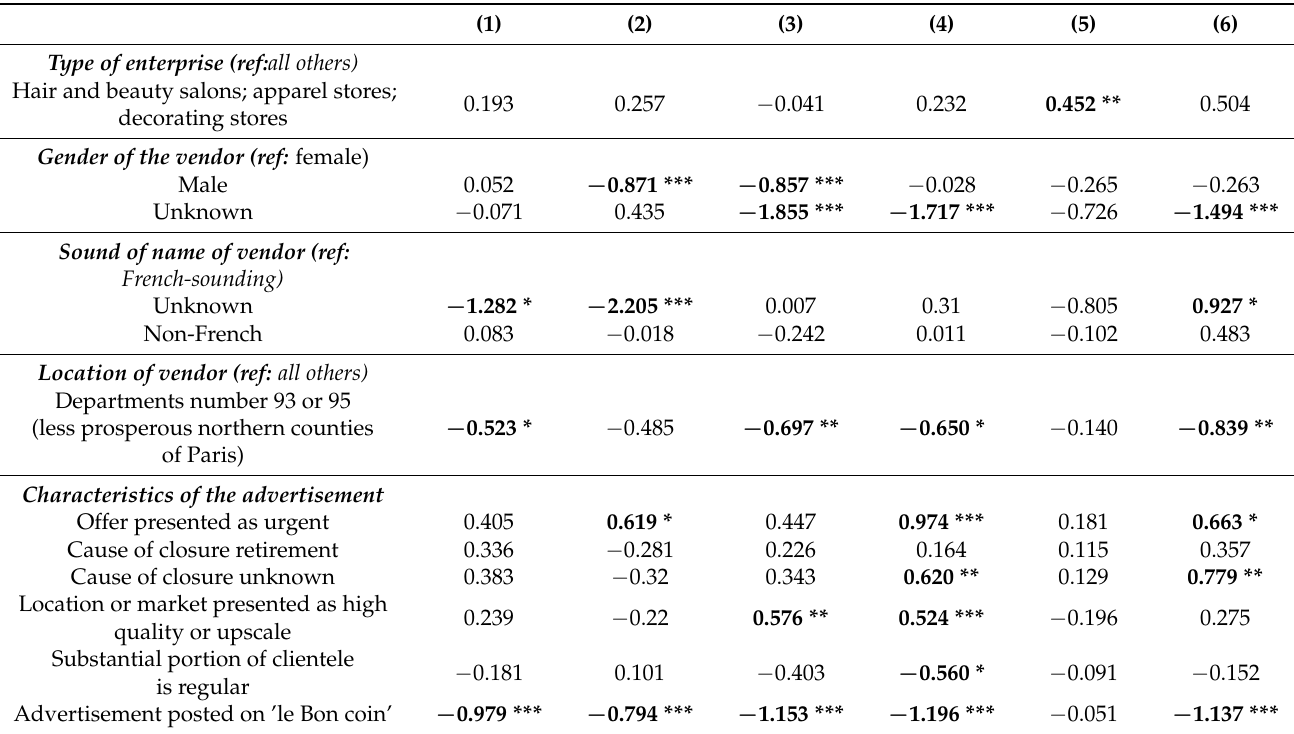
Table A2. Probit model of the probability of receiving a non-negative response for each of the six fictional inquirers (coefficient